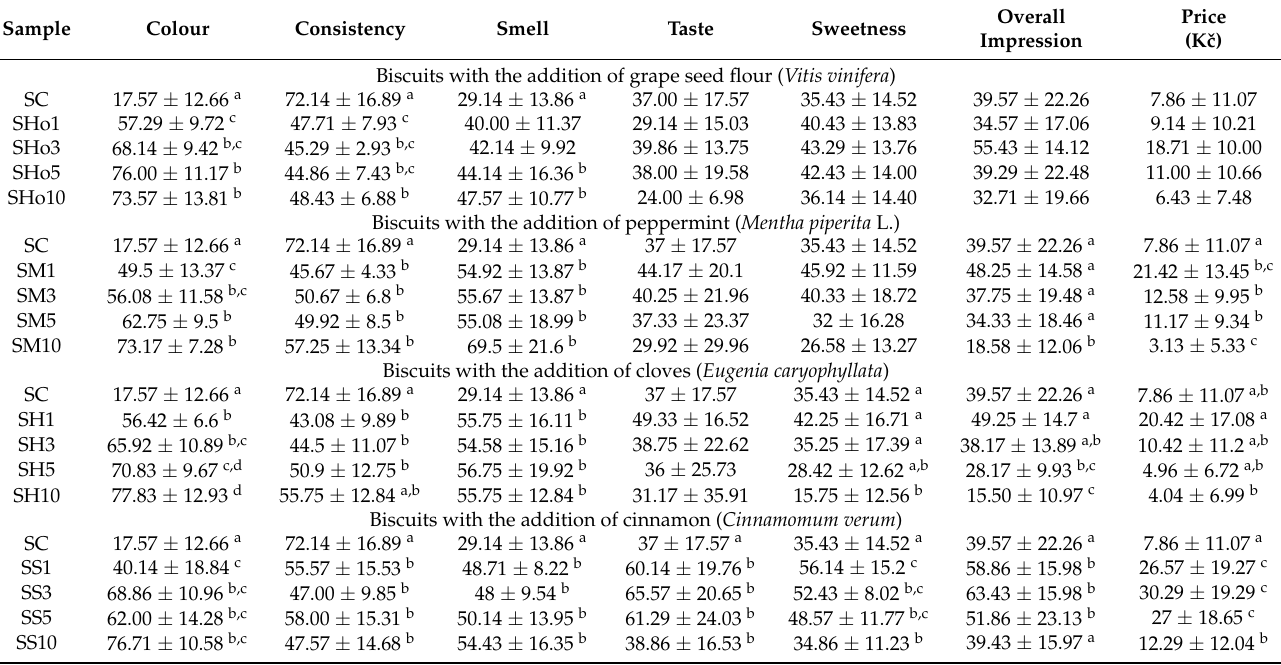
Table 3. The sensory evaluation of